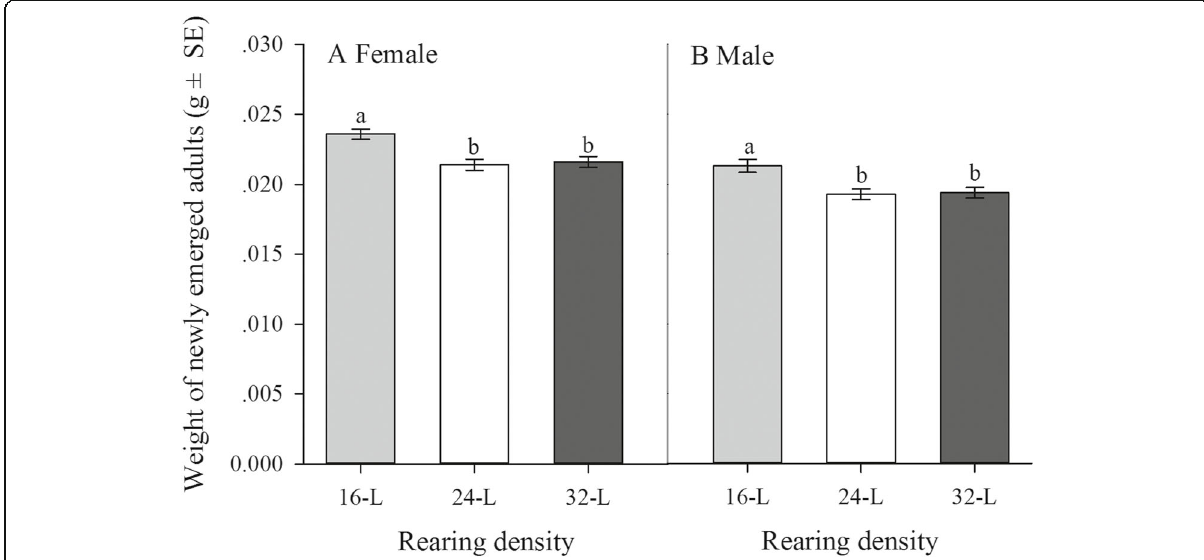
Fig. 5 Weights of newly emerged female ( A ) and male ( B ) adults. Different letters indicated significant differences among the three rearing